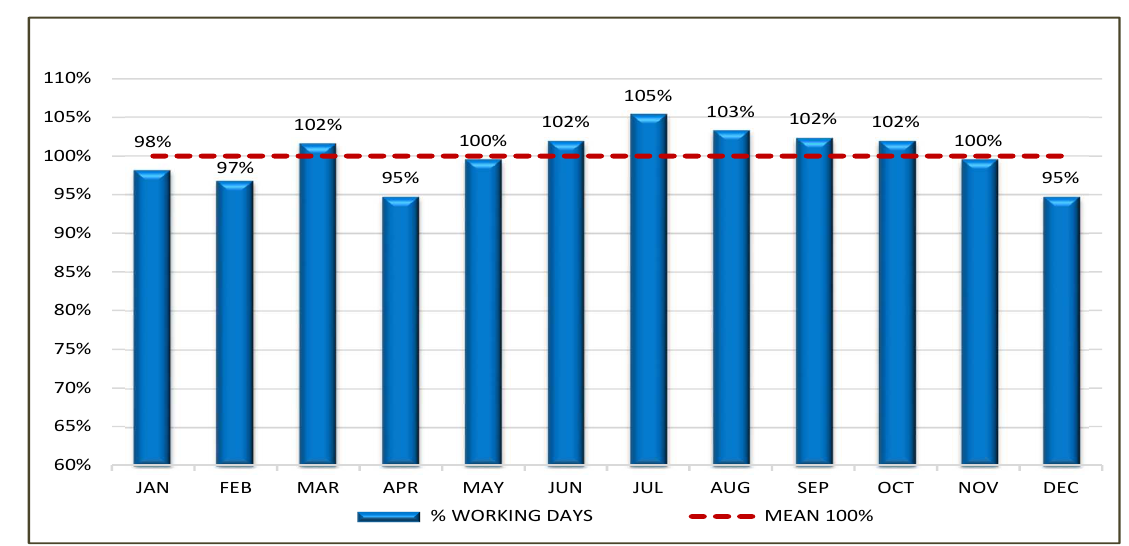
Fig. 3 Percentage of working days per month in the period 1999-2012. Source: own elaboration.